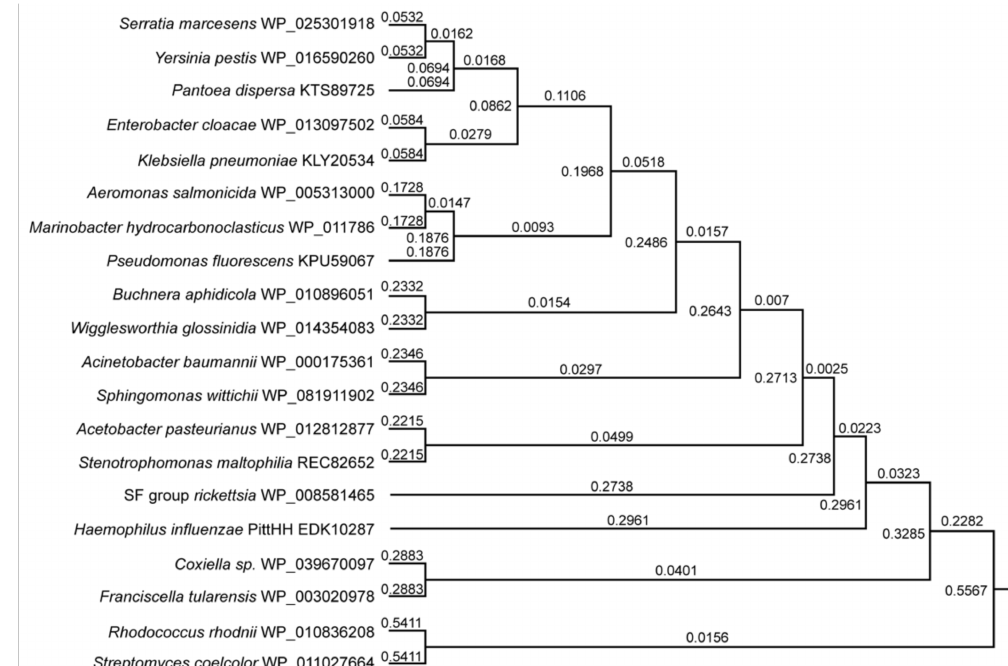
Figure 4. Phylogenetic analysis of biotin synthetase among 20 different bacterial species. Alignment (Clustal Omega, not shown) of these sequences showed an overall similarity of 71.6% (Blossum 62). Except for certain outliers, e.g., Streptomyces coelcolor and Rhodococcus rhodnii (which grouped closely with each other), most of the others aligned more closely, indicating that despite the wide variety of bacterial families, biotin synthetase is a highly conserved molecule in these